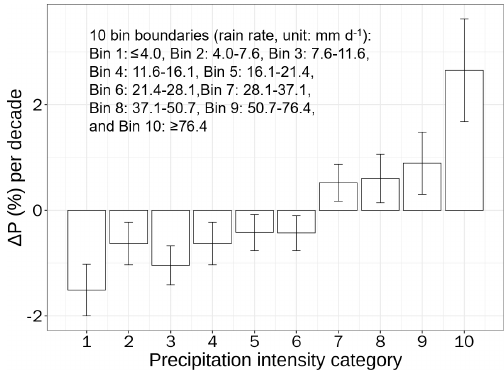
Figure 6. Linear trends in annual precipitation amount ( (cid:49)P ) falling within each of the 10 intensity bins in China during 1957–2005. The vertical line on top of each bar denotes 1 standard